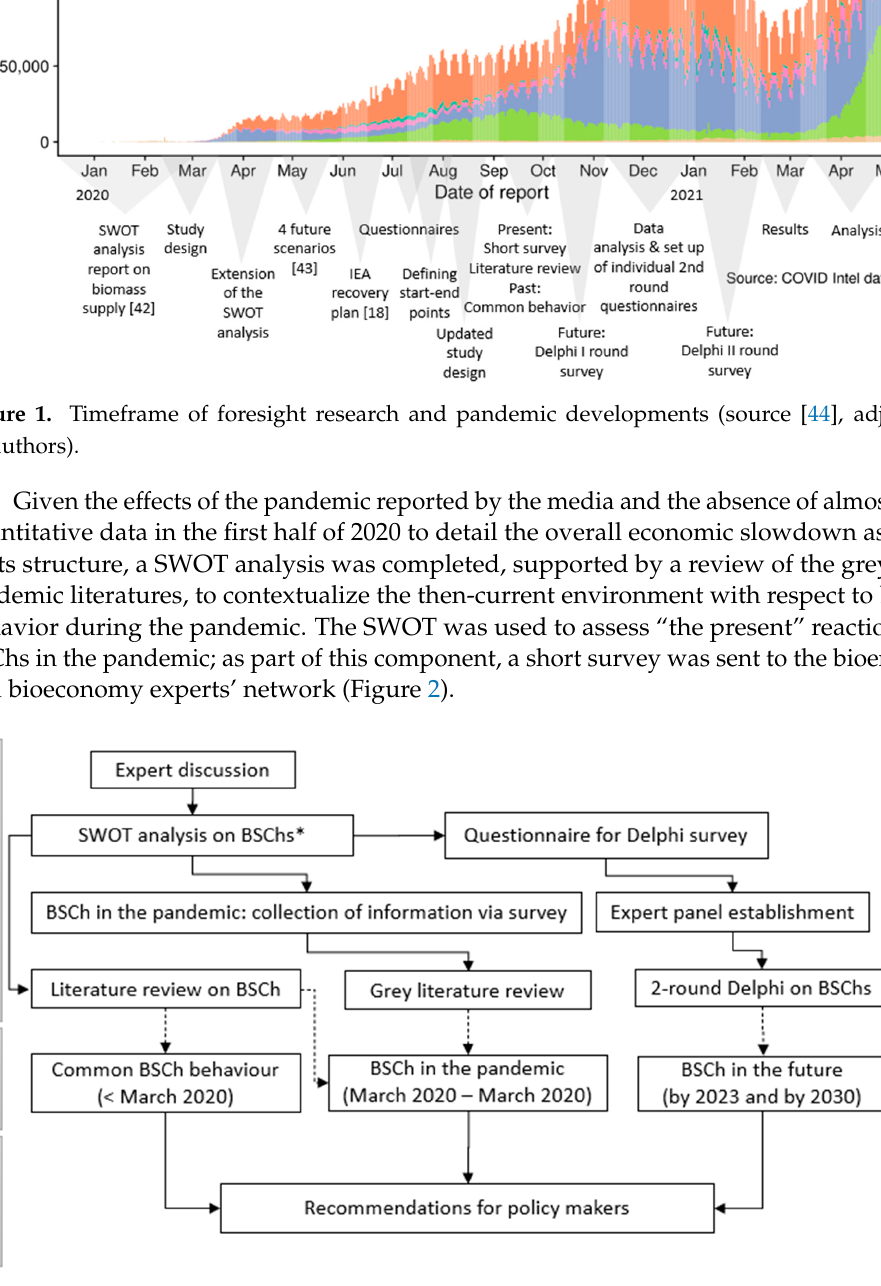
Figure 2. Foresight study design (* BSCh—biomass supply chain).